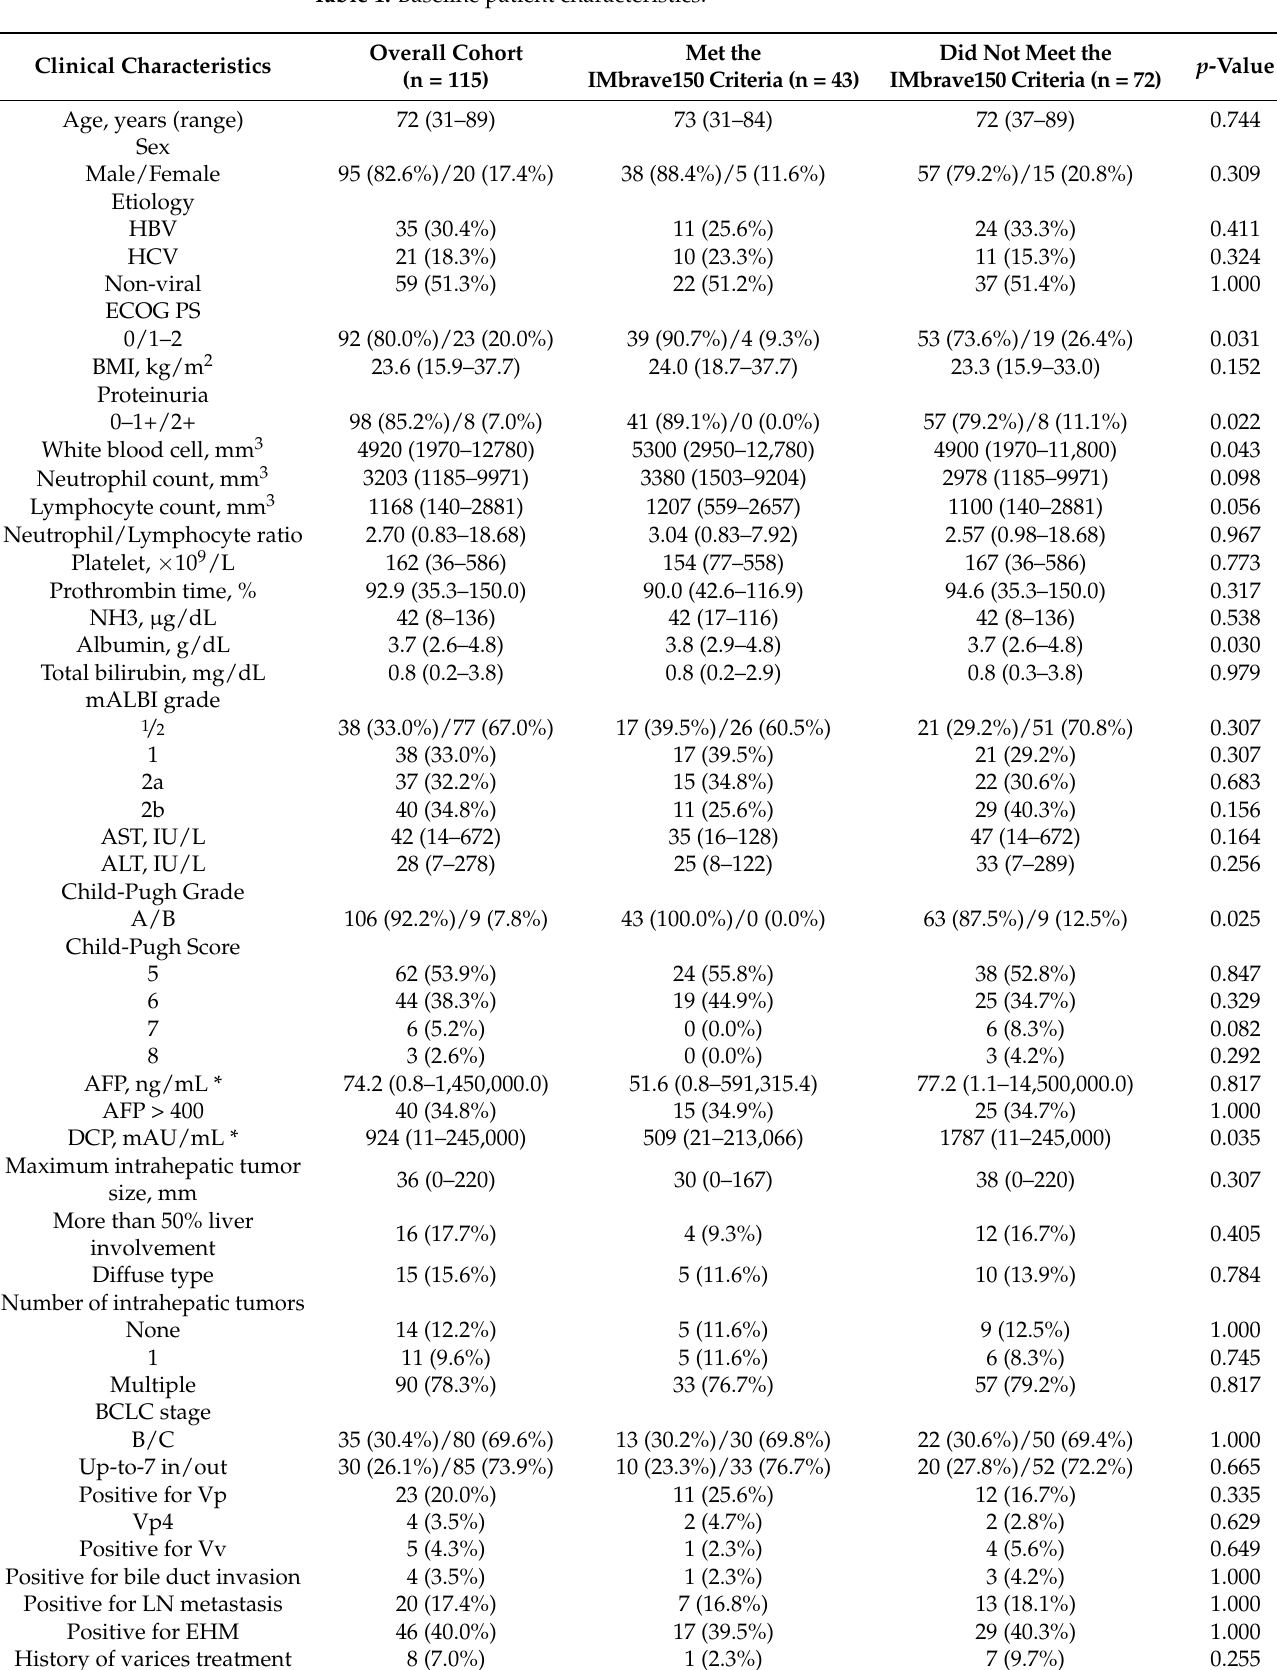
Table 1. Baseline patient